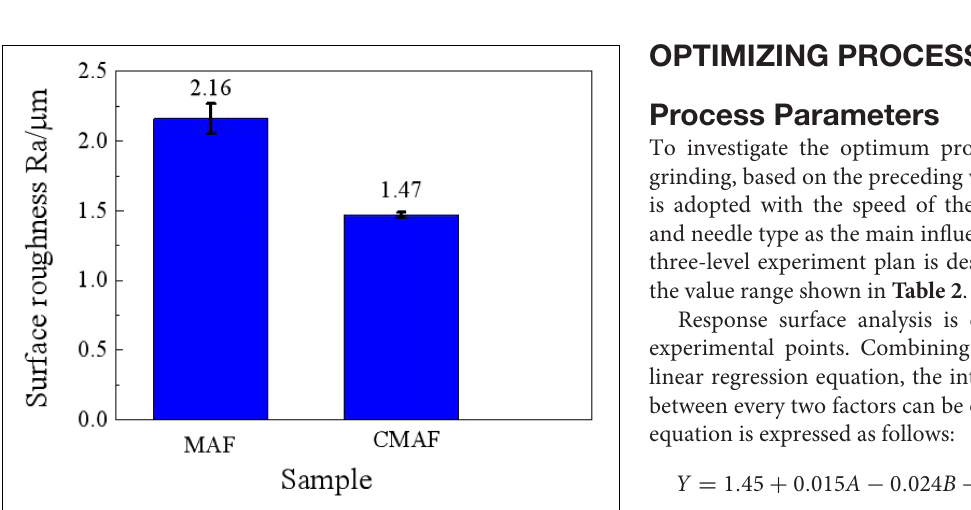
FIGURE 10 | Comparison of the microstructure on the workpiece. (A) Original. (B) After magnetic grinding. (C) After CAMG.